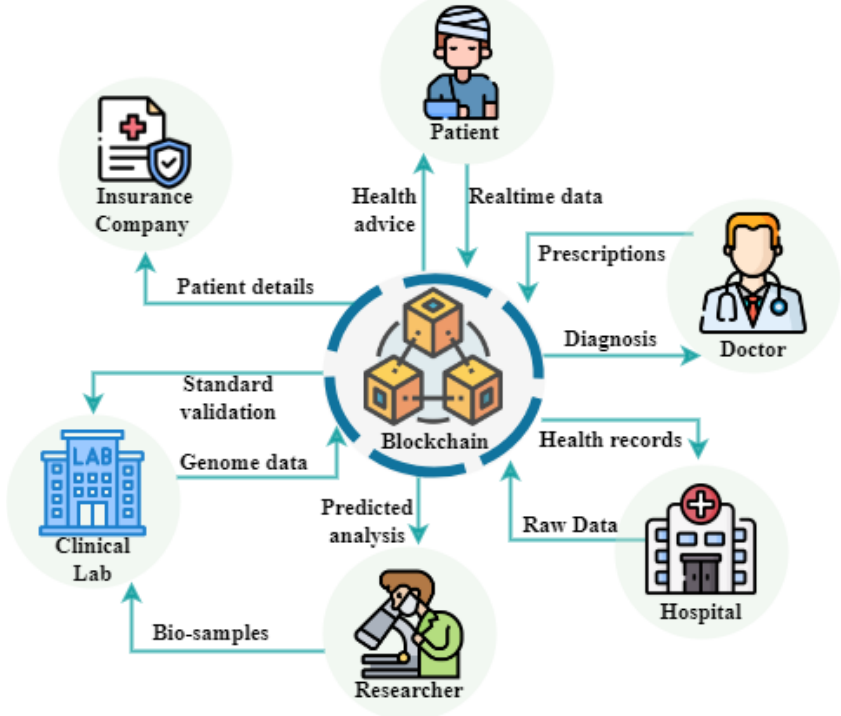
Figure 1. Blockchain technology use cases in the healthcare